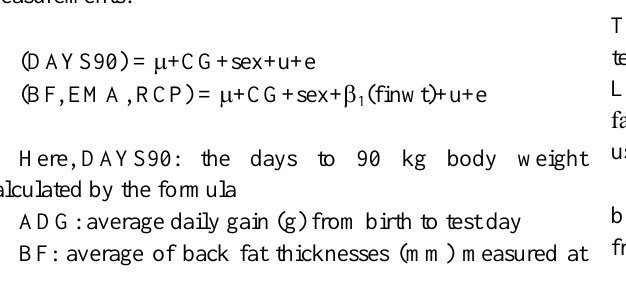
Table 1. Pedigree and performance data structure by breeds Total Breed